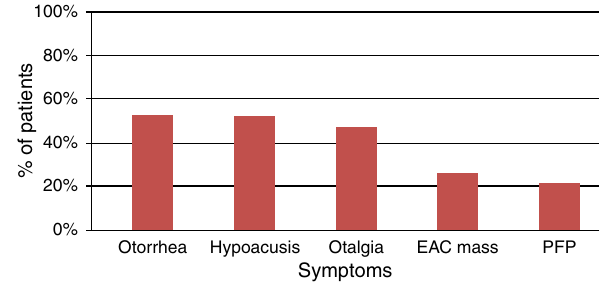
Symptoms reported by patients (PFP, peripheral facial